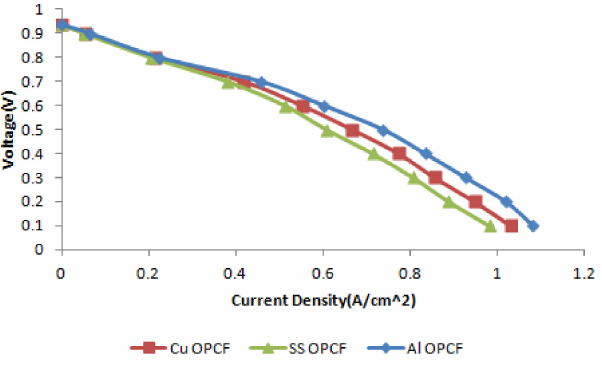
Figure 4. Hydrogen humidification temperature 40 ◦ C.